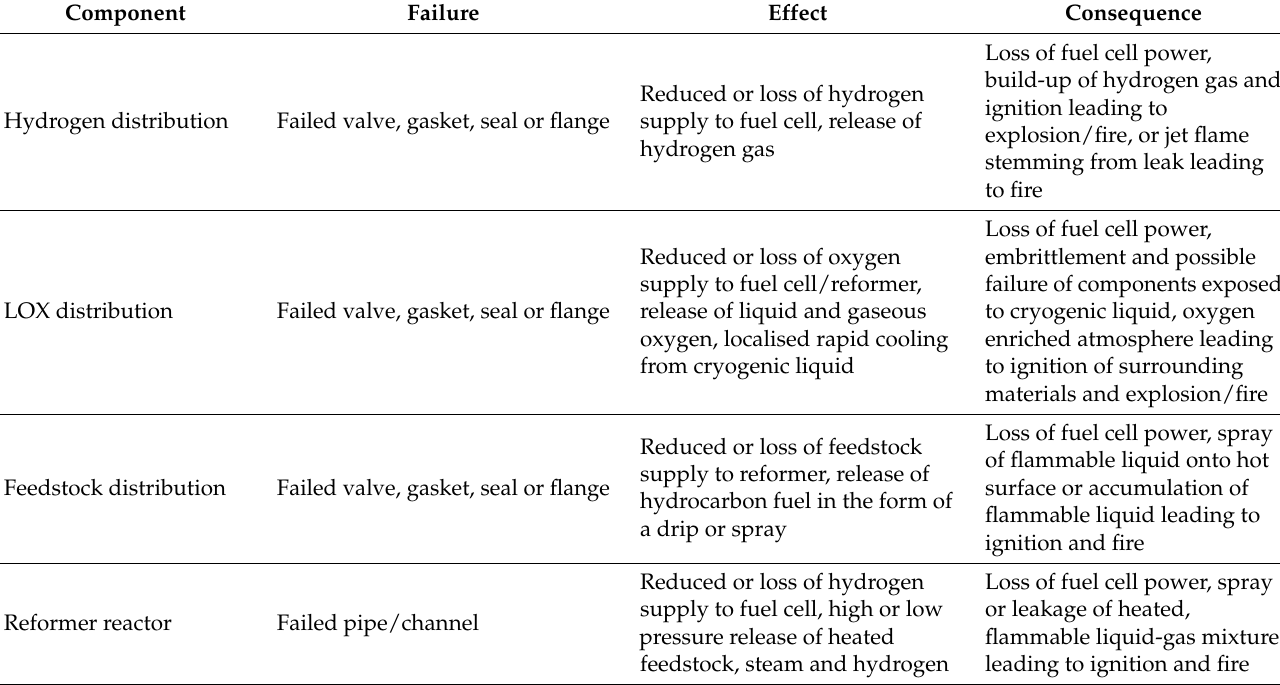
Table 4. Hydrogen Fuel Cell System Failures Leading to